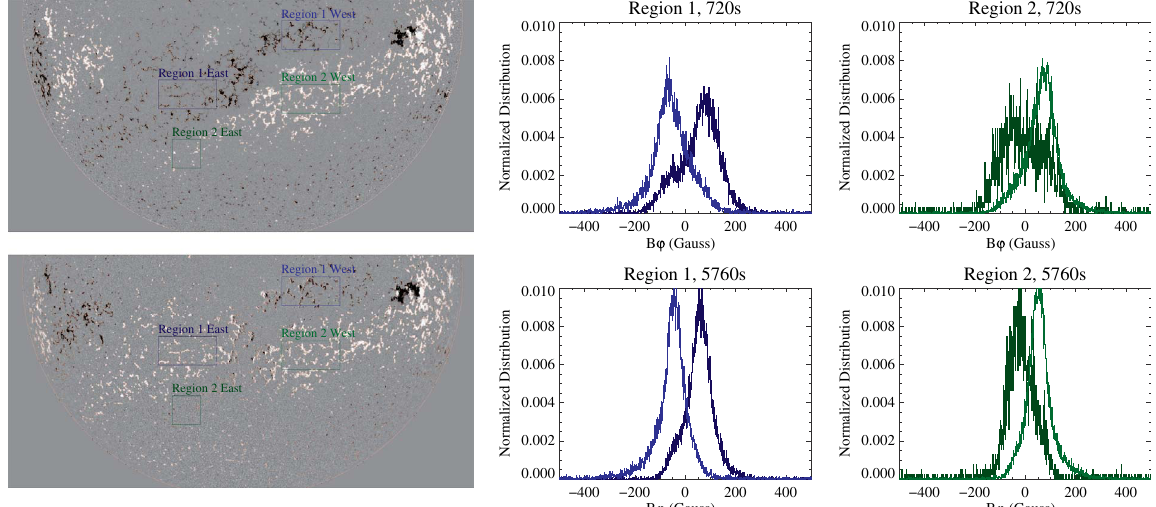
Fig. 4. Upper-left: half-disk image of radial B r fi eld (white/black correspond to positive/negative polarity), scaled to ±200 G. Outlines show pixels with the minimum-energy disambiguation applied (con fi d_disambig keyword (cid:6) 60), which are included in the distributions shown in right columns. Lower-left: half-disk image of zonal B u , scaled to ±100 G. Region 1 (blue boxes) corresponds to area of negative polarity fl ux in decaying fl ux region. Region 2 (green boxes) corresponds to a similar area but of positive polarity fl ux. Boxes outlined by lighter/darker color are located West/East of the central meridian. Middle column: distribution of the zonal ( B u ) component of the magnetic fi eld in the Region 1 for two (720 s and 5760 s) averaging. Right column: similar to middle column but for Region 2. Note: salmon (light pinkish – orange) contours that outline pixels with the minimum-energy disambiguation mask underlying black/white magnetic fi elds. To see both the magnetic fi eld and the contours, the PDF fi gure needs to be magni fi ed by 300% or